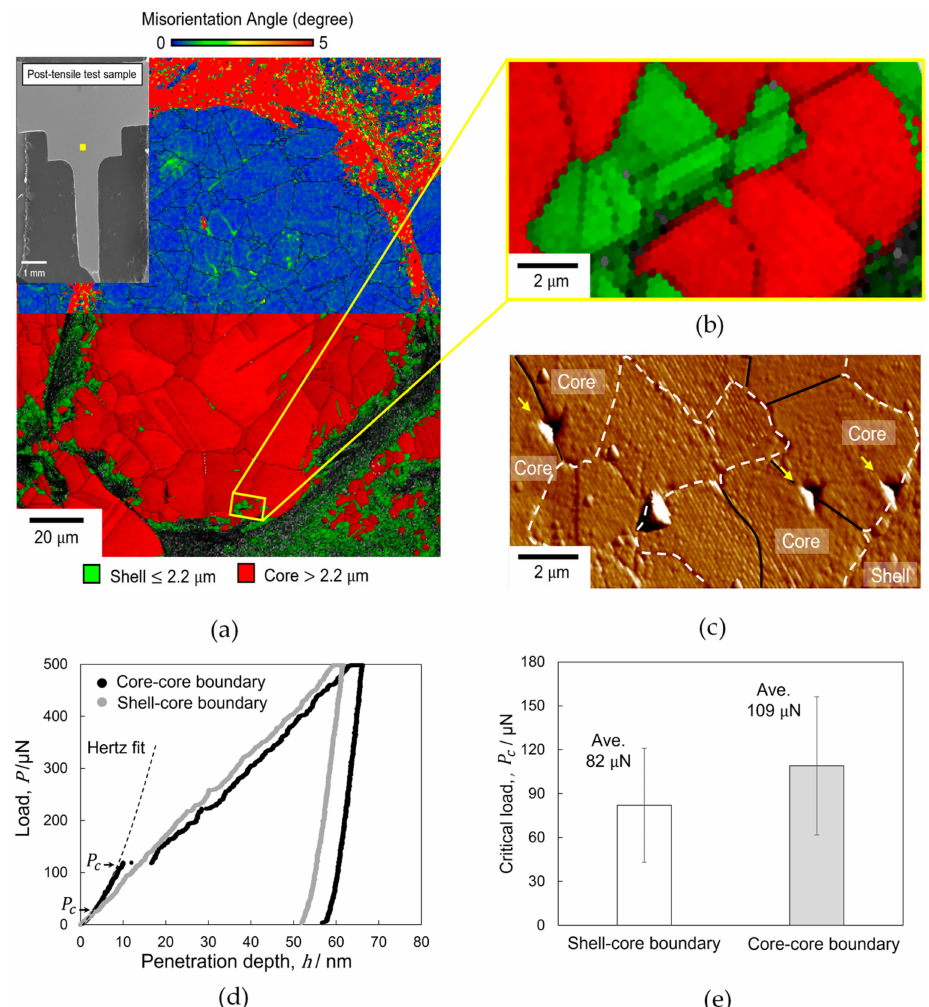
Figure 4. ( a ) KAM map (top) and IQ map overlaid with the color-coded map indicating the shell and core regions (bottom) with a 0.5 µ m step size. The inset shows the observed position on the post-tensile test sample. ( b ) Magnified image of the shell and core region in the yellow box in ( a ) with higher resolution of EBSD scan step size of 0.2 µ m. ( c ) Scanning probe microscopy image of the area shown in ( b ) after nanoindentation at the core–core and shell–core boundaries, which are indicated by yellow arrows. The white dotted line indicates the shell–core boundary. ( d ) Nanoindentation load–displacement curves of the core–core and shell–core boundaries with arrows indicating the critical load, P c , for pop-in phenomena. ( e ) Bar graph of the average P c of the core–core and shell–core grain